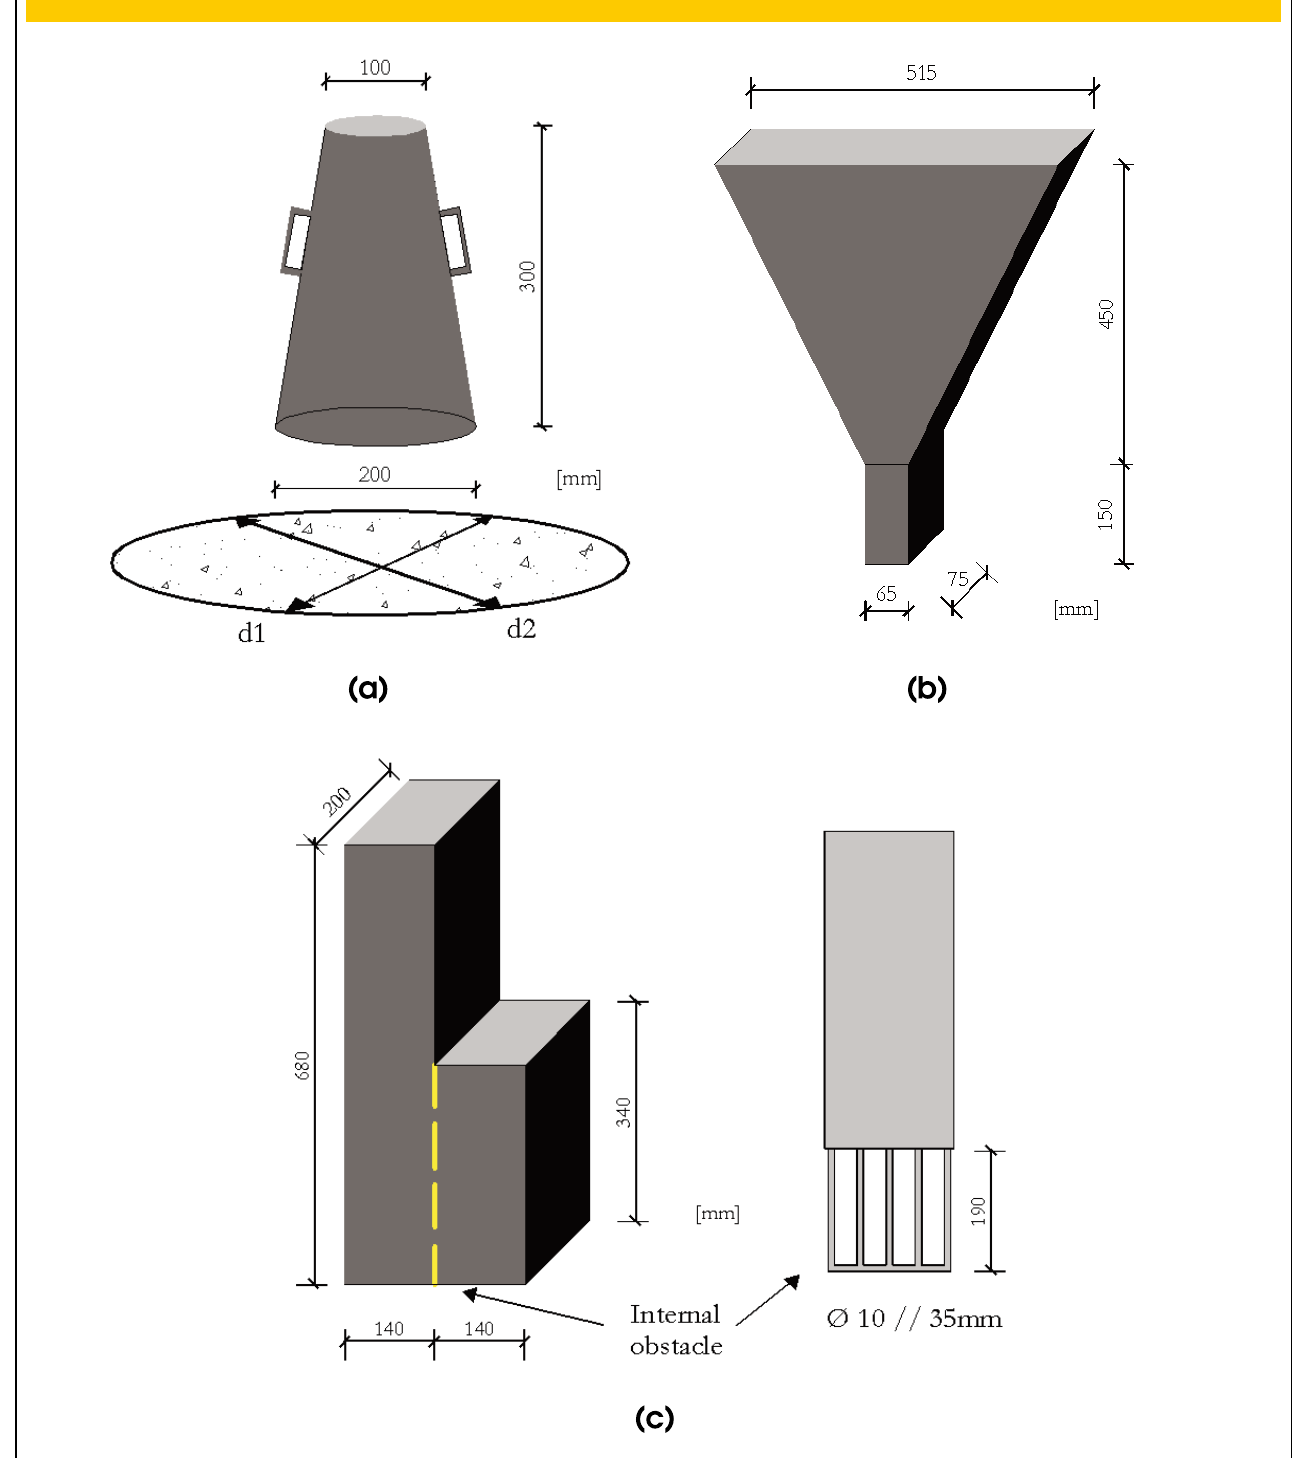
in the fresh state, see Figure 2. The Slump-flow test is used